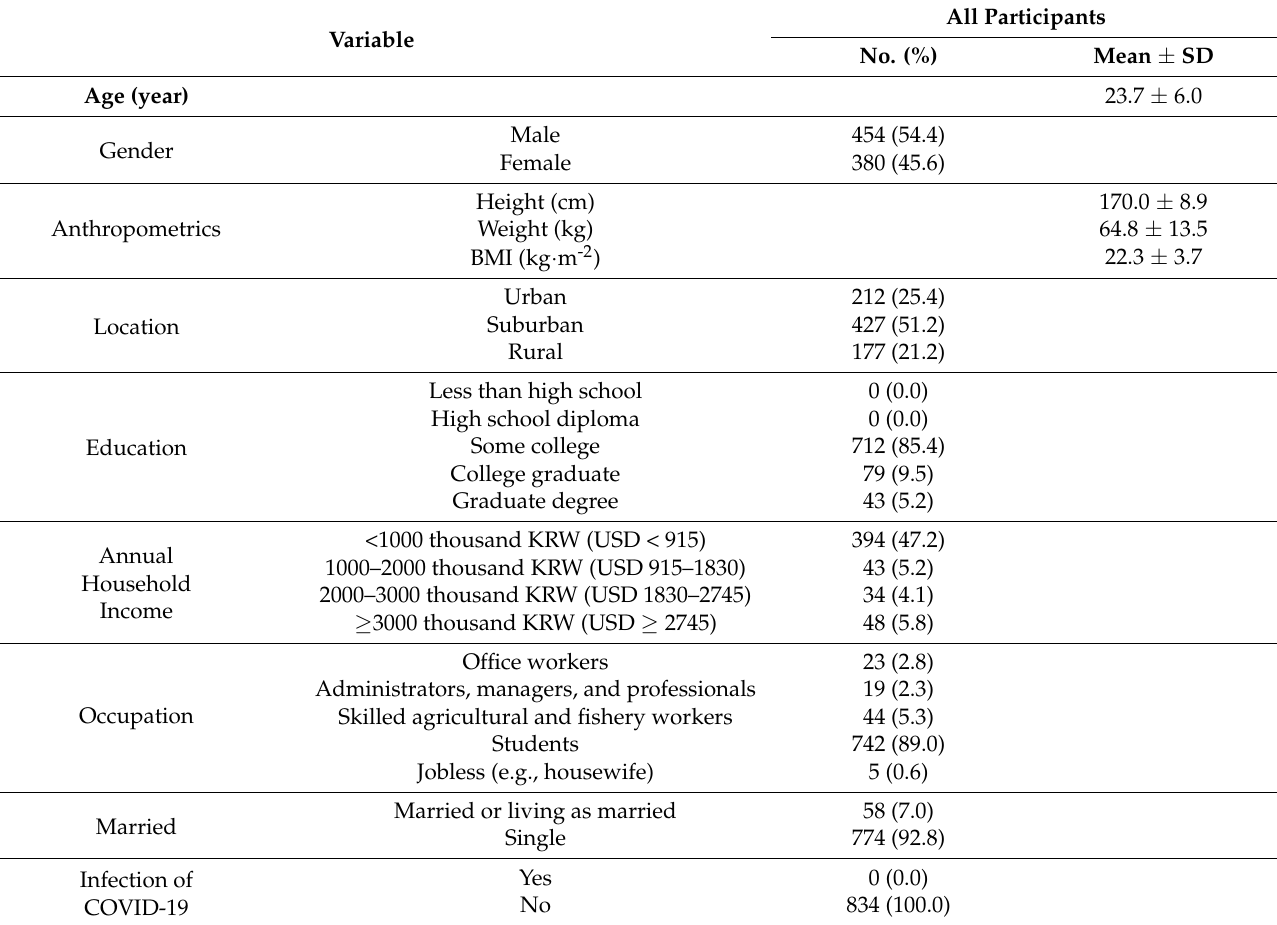
Table 1. Characteristics of Participants ( n =